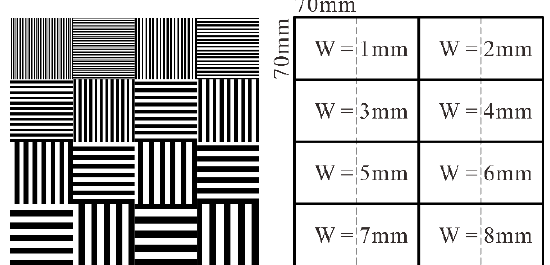
Figure 7. Chart for checking the resolution of acquired images 5.1 SR by using a single LR image (SR-S)